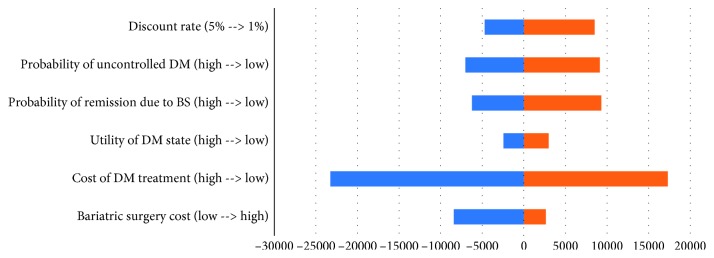
Tornado diagram.